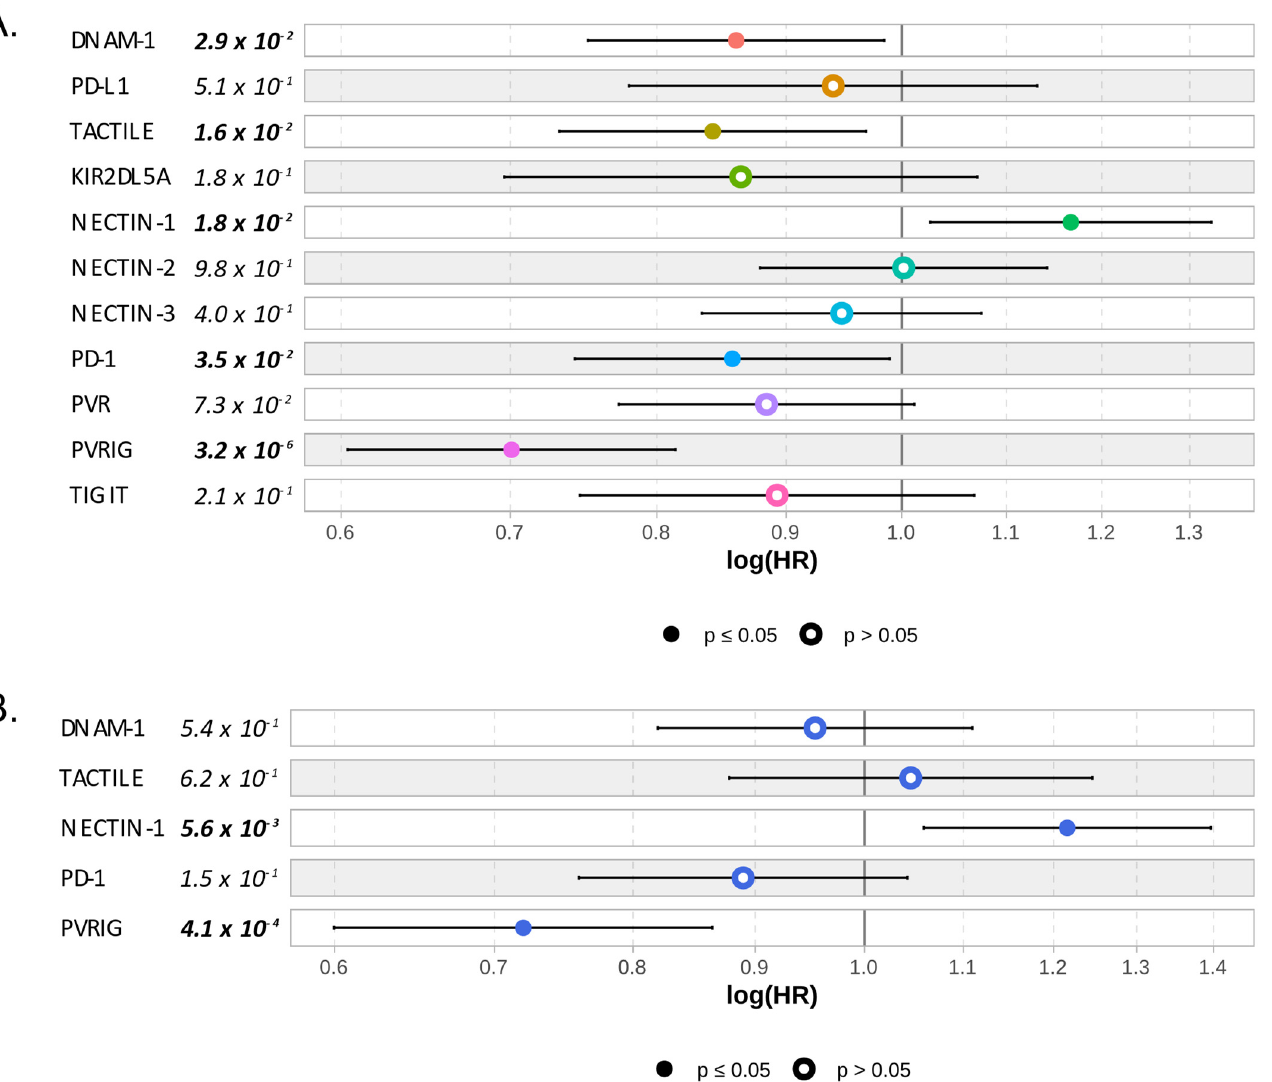
Figure 3. Correlation between gene expression of each member of the TIGIT/DNAM-1 axis and overall survival: ( A ) Univariate—one color by Cox regression—and ( B ) multivariate correlation analyses between each member of the TIGIT/DNAM-1 axis and OS. PD-1/PD-L1 axis was added for references. Cox model representation. Significant p -values ( p ≤ 0.05) are written in bold and represented with plain circles.